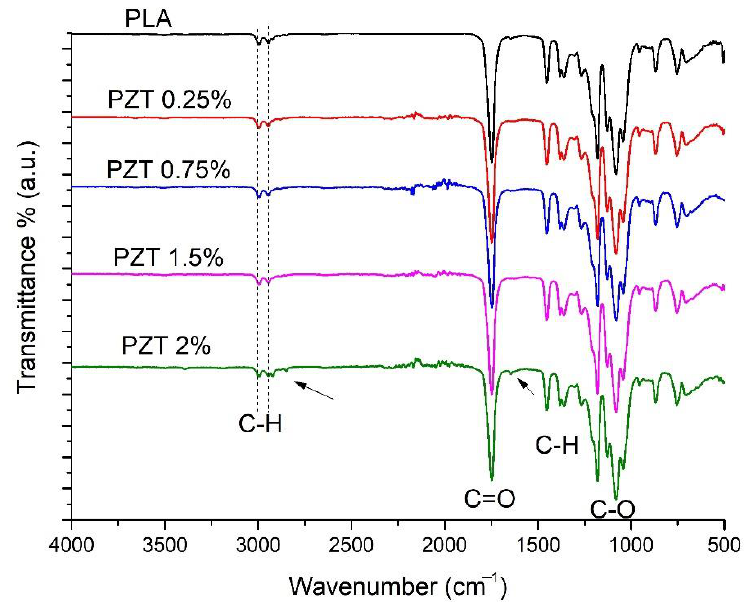
Figure 1. FTIR spectra of neat PLA and nanocomposite PZT at different concentrations.